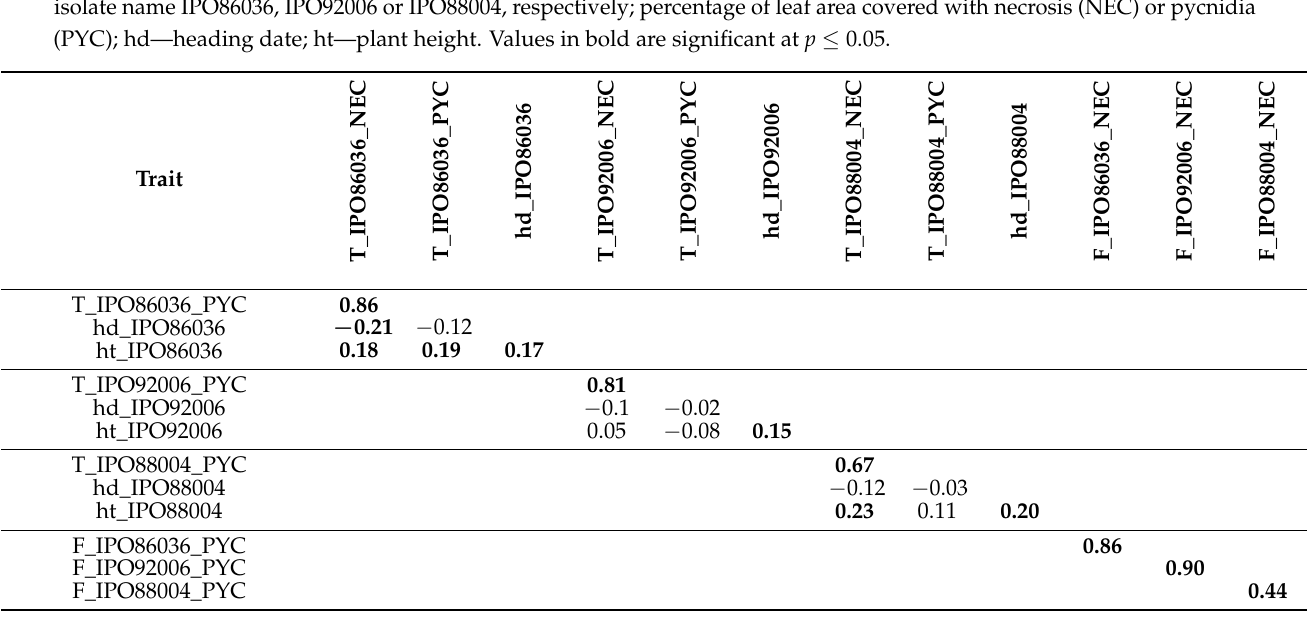
Table 3. Pearson’s correlation coefficients between plant height, heading date and percentage of leaf area covered by necrosis/pycnidia. Data set name consists of the following designations: T—polytunnel or F—plant growth chamber;